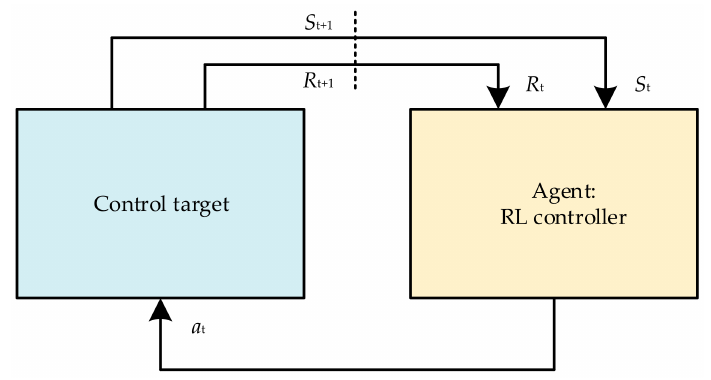
Figure 7. Basic principles of RL